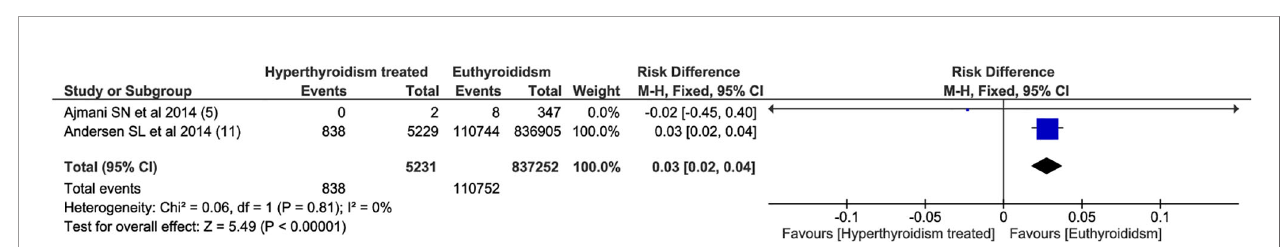
FIGURE 4 | Forest Plot: Spontaneous Abortions.